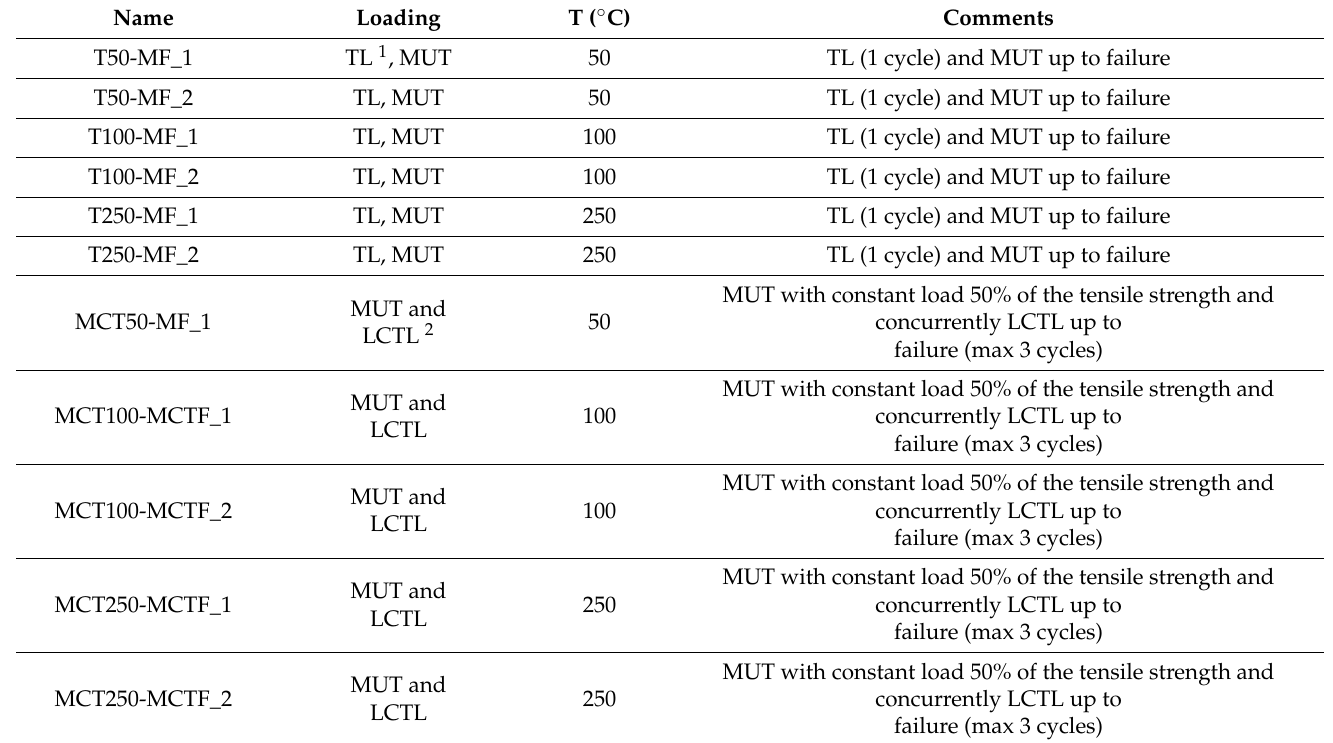
Table 3. Detailed information of experiments under elevated temperatures.